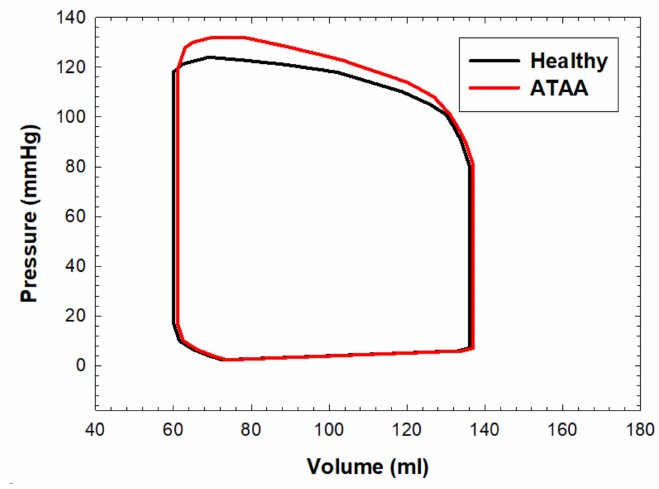
Figure 10. Pressure–volume loop of the left ventricle for the healthy and ATAA